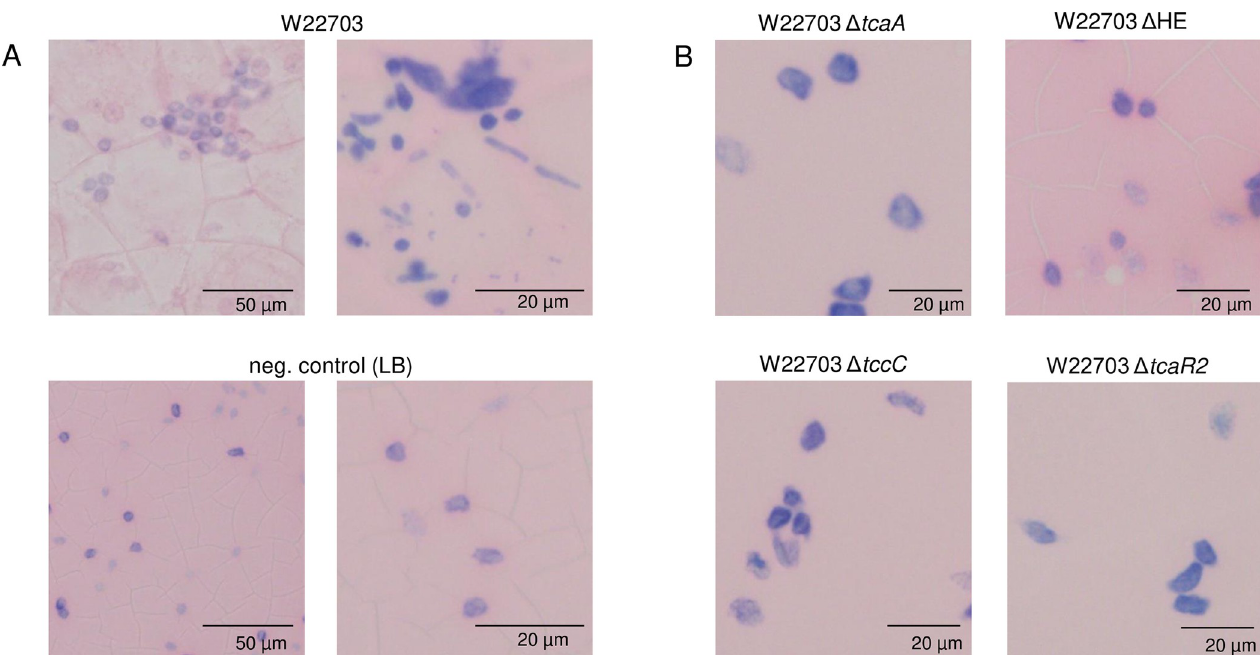
Fig 7. Hemocyte morphology 24 h p.i. (A) Hemolymph cell preparations from G . mellonella orally infected with 6.1 × 10 5 CFU of W22703 or treated with LB medium as control. (B) Hemocytes of larvae after application of four W22703 mutants, showing cell morphology similar to those of the controls. Hemocyte aggregation and deformation was visible only upon infection with W22703. Hemolymph preparations were fixed with methanol and stained by Giemsa solution. Photos of representative preparations are shown; cells vary in size, the scale is indicated. An Olympus BX53 microscope (Olympus Europa, Hamburg, Germany) was